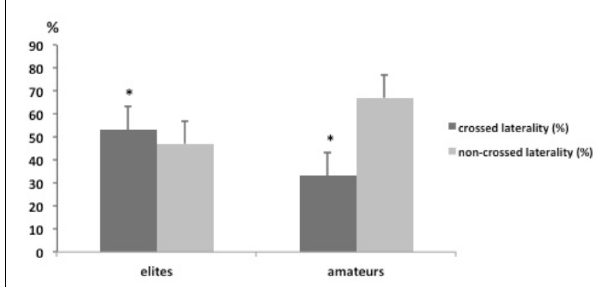
FIGURE 2 | Crossed laterality (e.g., dominant hand or/and dominant foot opposite to the dominant eye), of elites and amateurs players. ∗ Significantly different between elites and amateurs, p <